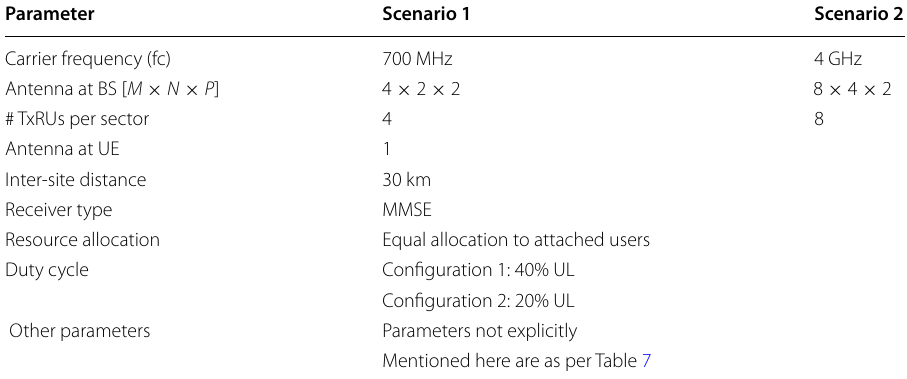
Simulation time